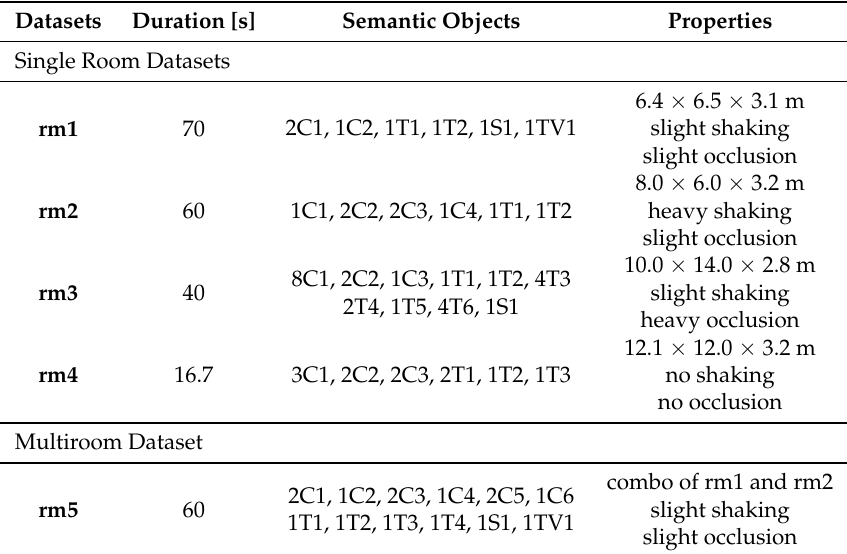
Table 1. Provided RGB-DS